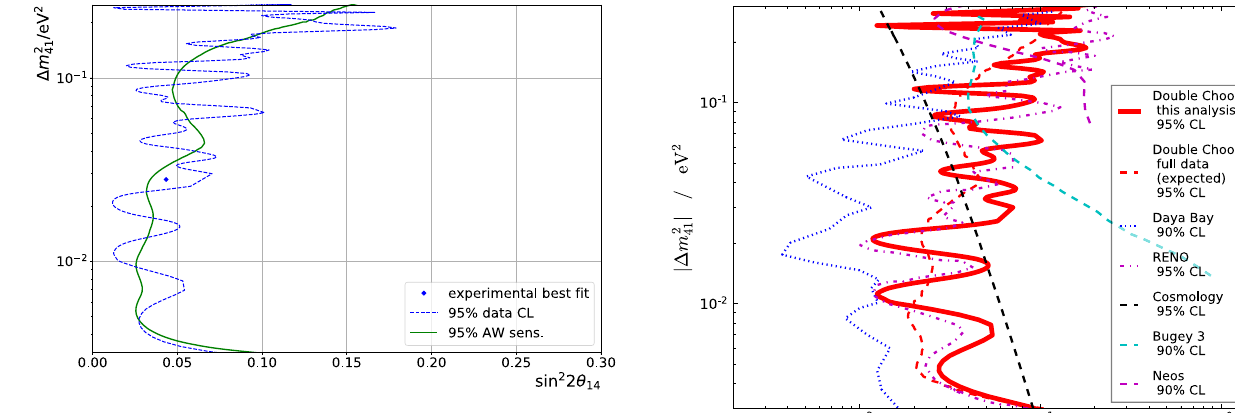
Fig. 11 Upper limit (dotted blue line) at 95% C.L. for sin 2 2 θ 14 as a function of Δ m 2 . The black dot indicates the position of the global 41 best fit. The green solid line corresponds to the AW-sensitivity maximum likelihood. Such a strategy has been followed e.g.